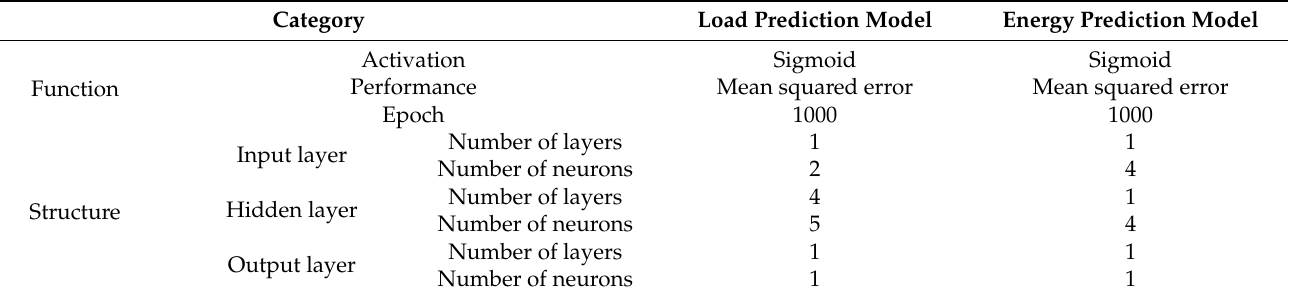
Table 2. Parameter composition of the ANN